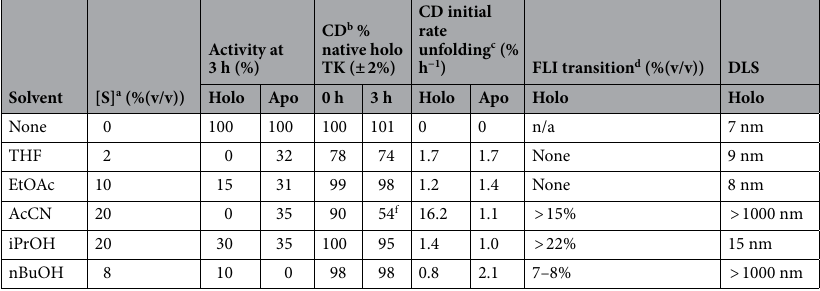
Table 2. Effects of polar organic co-solvents on TK structure and activity after 3 h at 25 °C. a Concentration of solvent added. b CD % Native based on signal at 222 nm, except EtOAc which is based on signal at 223 nm to avoid a high dynode voltage at < 222 nm. c Initial rate of unfolding was determined by converting mean residue ellipticity into % loss of native structure, and by subtracting the baseline rate determined in the absence of solvent. d Fluorescence intensity. e Time dependence of fluorescence intensity (approximate time taken to reach equilibrium). f Aggregated after 4.5